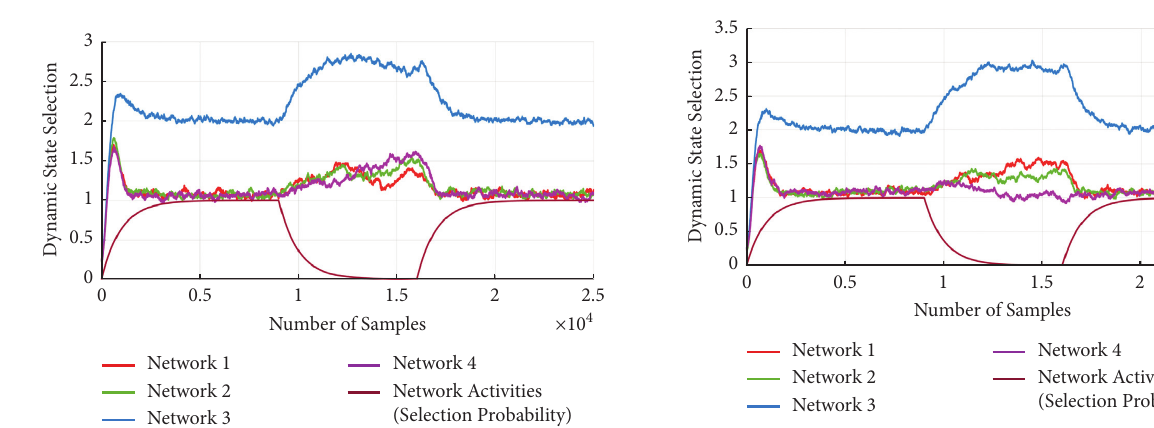
Figure 22: Effect of threshold on network connectivity for threshold � 2 ( S l � 9).